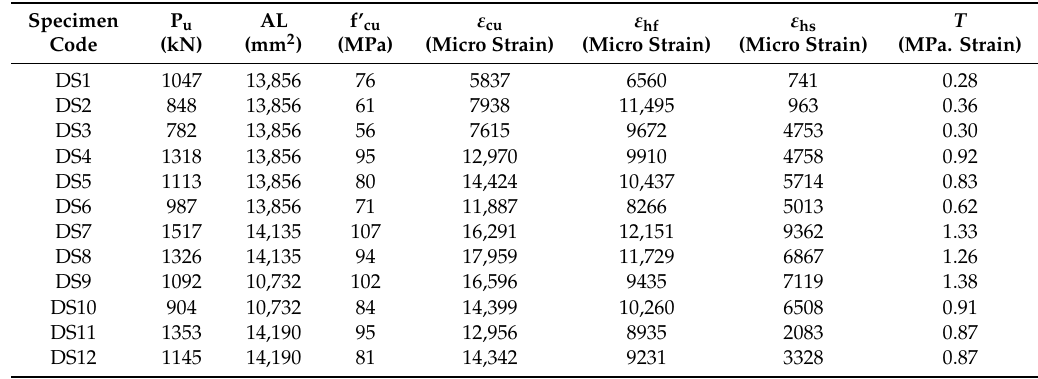
Figure 5. Failure mode of tested specimens. Table 3. Stress–strain results.